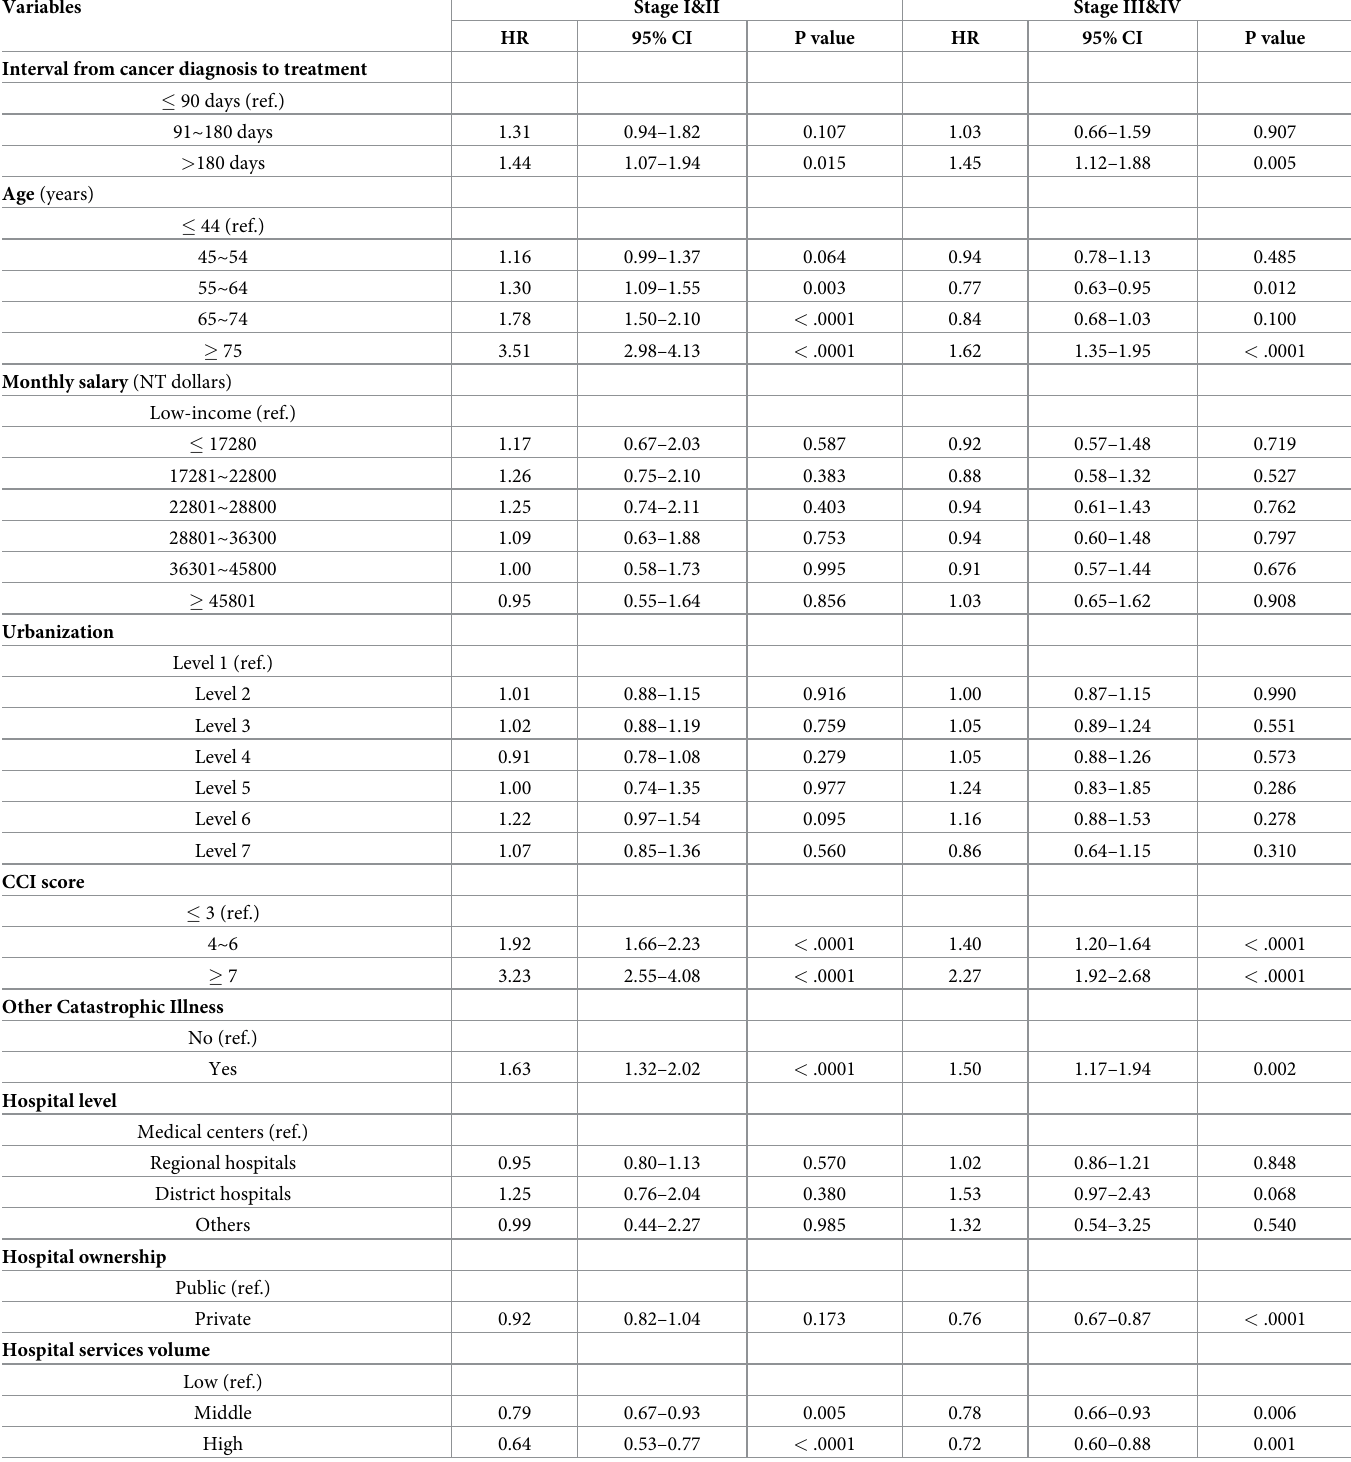
Table 4. Cox proportional hazard model: Factors associated with